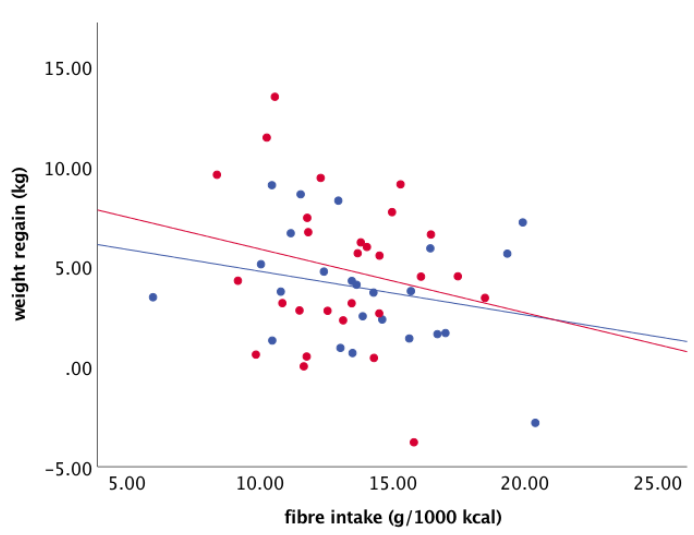
Figure 6. Associations between fibre intake during FU and weight regain in the participants with normoglycemia (≤5.6 mmol/L) and those with elevated FPG (>5.6 mmol/L) at baseline. Blue dots/line: FPG ≤ 5.6 mmol/L; red dots/line: FPG > 5.6 mmol/L ( n = 49).